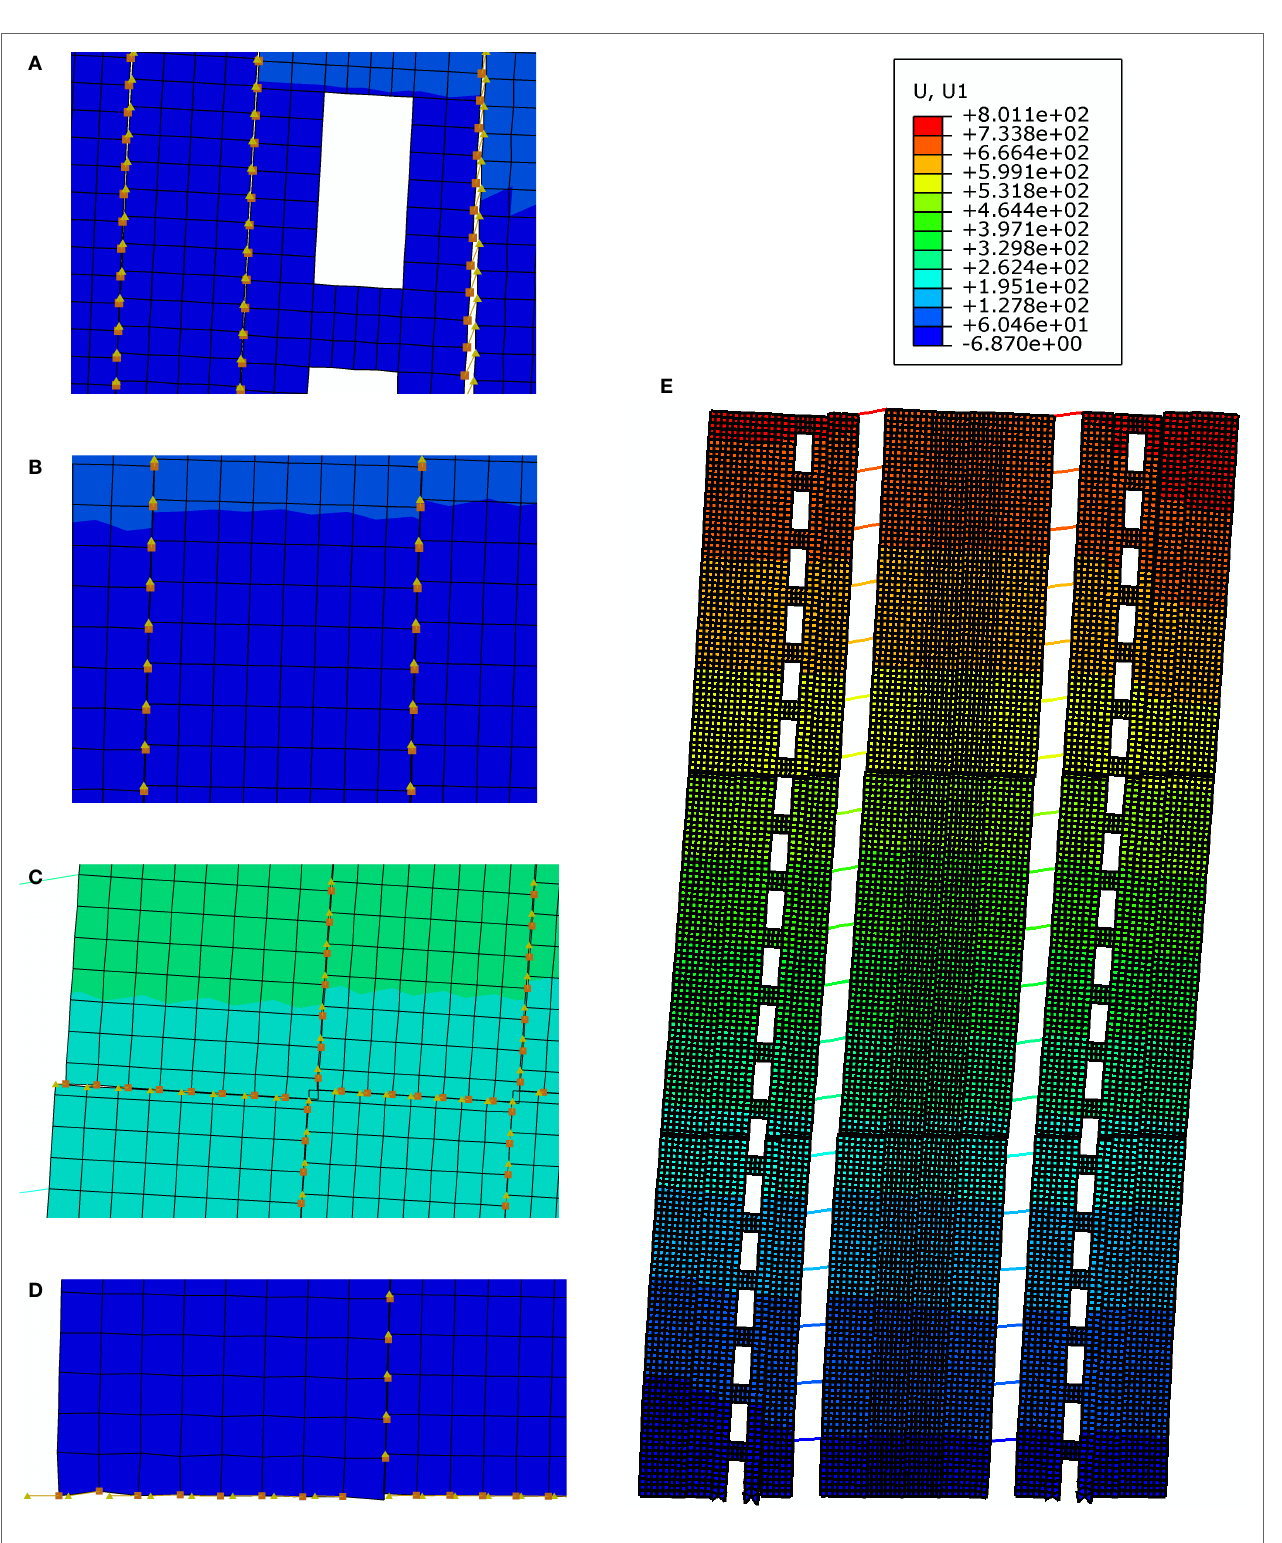
FigUre 9 | Deformation of connections and building finite element (FE) model (scale factor is 5): (a) vertical joints of shear wall, (B) vertical joints of core, (c) connections between core panels, (D) connections of core panels, and (e) deformation of FE